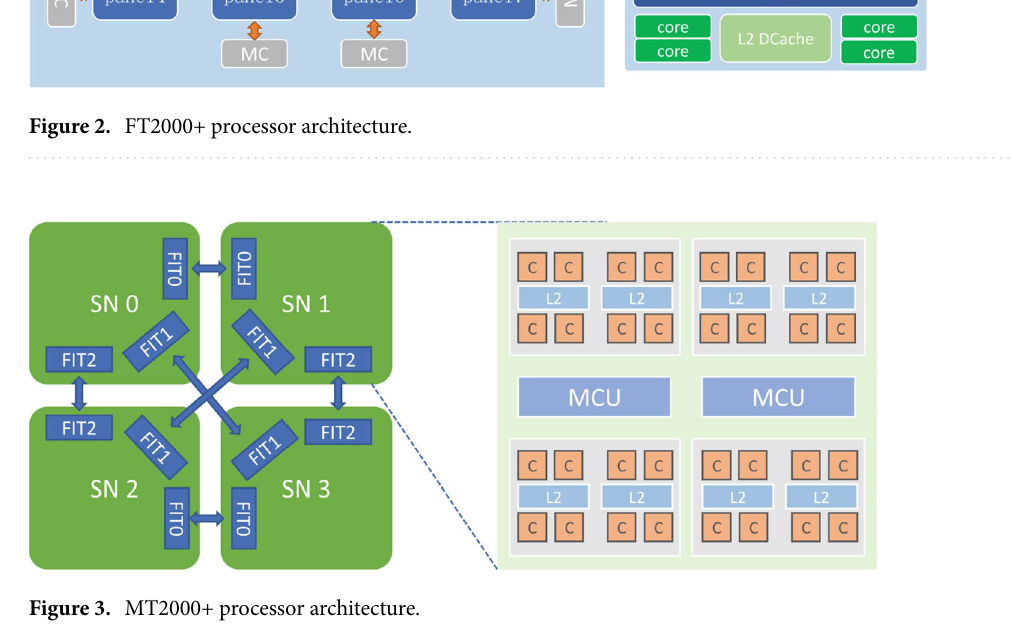
Figure 3. MT2000+ processor architecture.